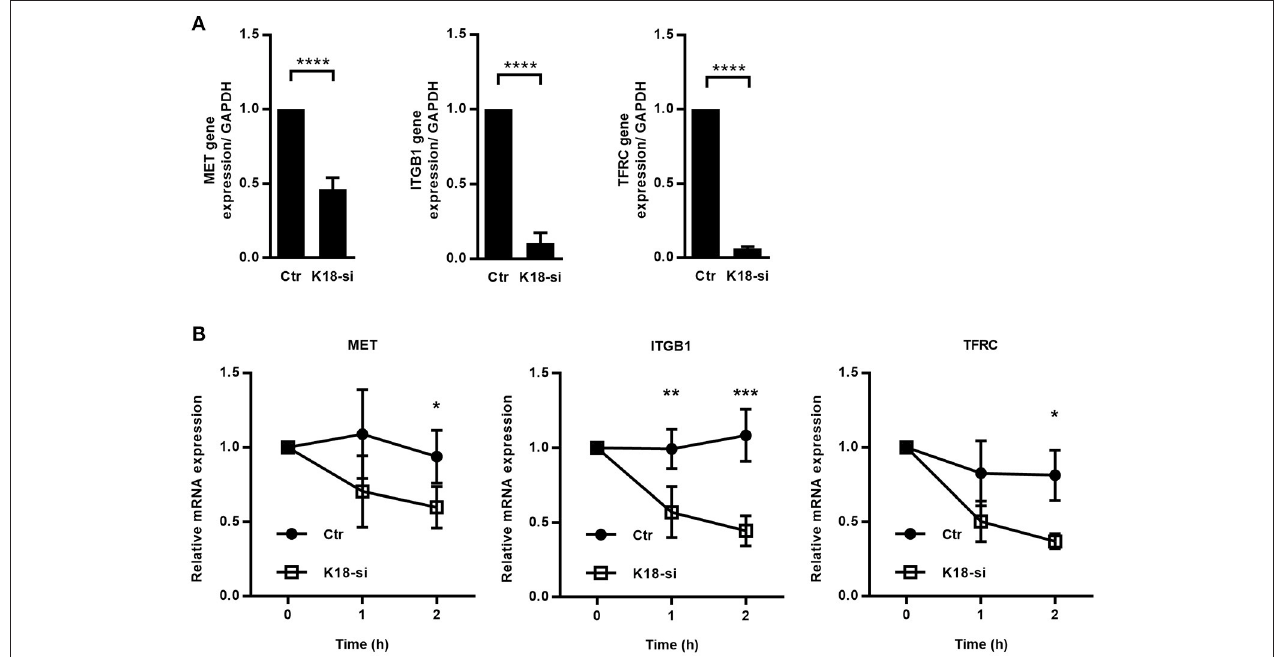
FIGURE 8 | K18 favors expression of cMet, TfR and integrin β 1, by promoting transcript stability. (A) mRNAs were extracted from control (Ctr) and K18-depleted (K18-si) HeLa cells and qRT-PCR was performed using GAPDH as a housekeeping gene. Data are represented as mean ± S.E. from at least three independent experiments (B) Control and K18 depleted cells were left untreated or were treated with 5 µ g/ml of the transcriptional inhibitor Actinomycin D for different periods of time. Transcript levels for cMet, TfR, and integrin β 1 were determined by qRT-PCR. Fold changes are relative to GAPDH and were normalized to untreated control. Results are from at least three independent experiments. Statistically significant differences are indicated: * p < 0.05; ** p < 0.01, *** p < 0.001, and **** p <